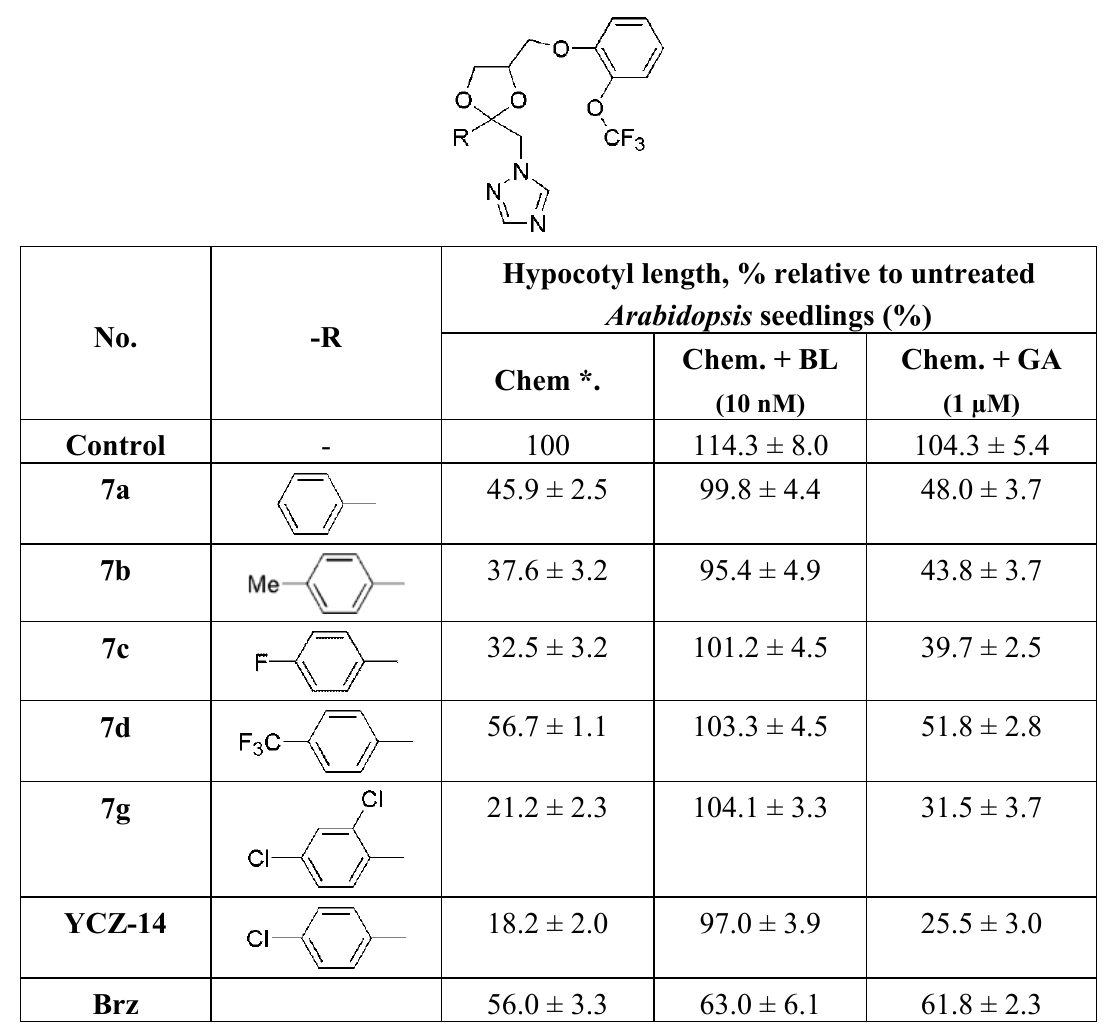
Table 2. Retardation of Arabidopsis seedling growth by triazole derivatives and rescue of growth by BL and